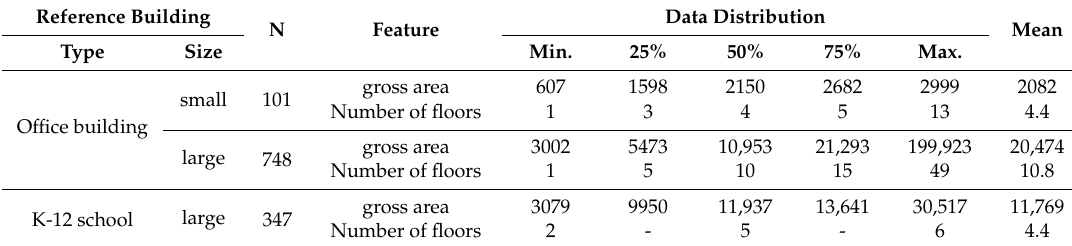
Table 4. The size distribution by building type and the selected representative